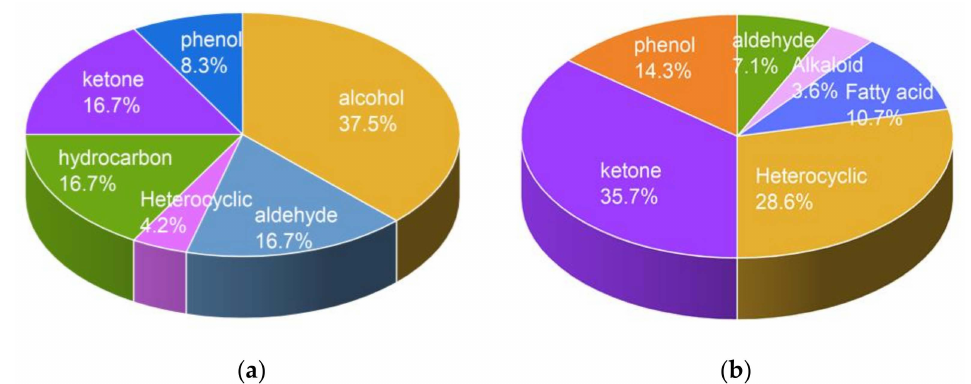
Figure 3. Chemical patterns of germinating barley seeds (Scope CL) based on ( a ) HS-SPME and ( b ) liquid absorption coupled with GC-MS. The data analyzed by three replications. Each area represents the percentage of the number compounds in the specific group.